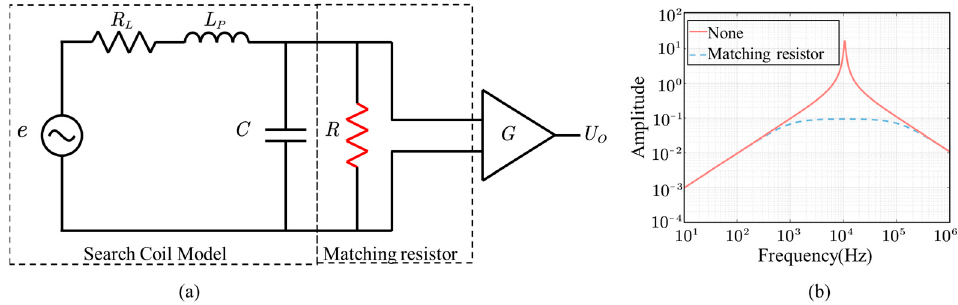
Figure 3. Equivalent circuit of the search coil with matching resistor ( a ) and its frequency response ( b ).